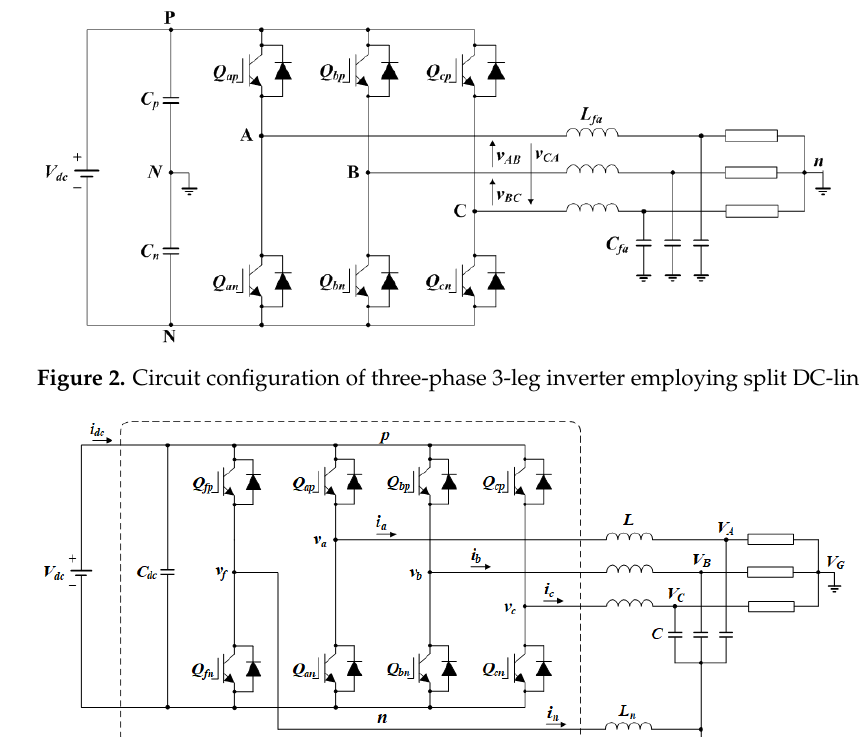
( b ) Figure 4. Photograph of three-phase 4-leg inverter: ( a ) Power stage; ( b ) controller.